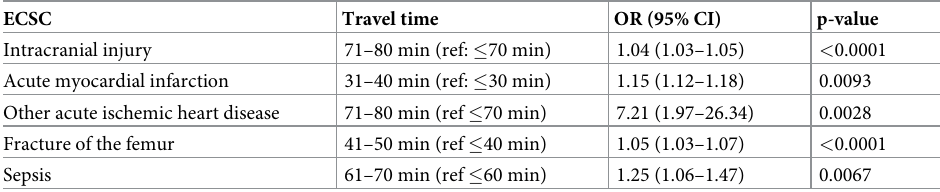
Table 4. Odds ratio for the adjusted 30-day mortality by travel time on multiple logistic regression analysis �